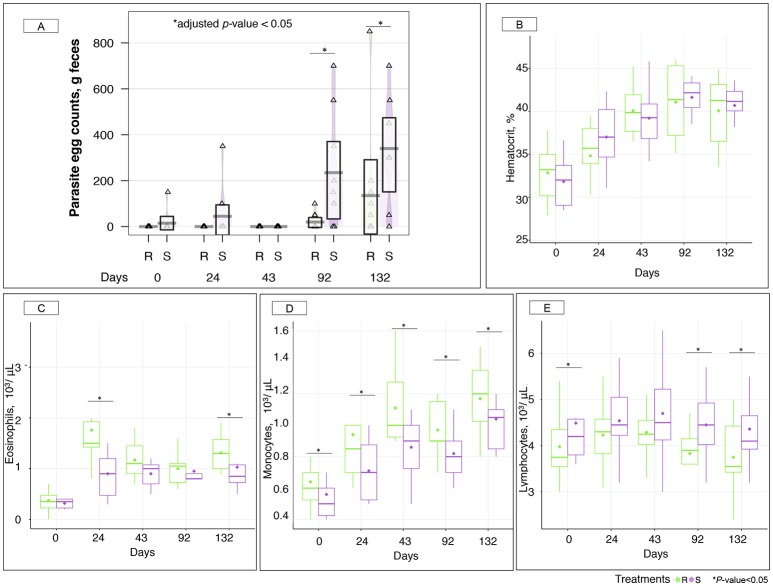
Parasite fecal egg counts and hematological parameters between susceptible and resistant animals across time. (A) Boxplot of the log parasite fecal egg counts (eggs/g feces) in susceptible (S) and resistant (R) animals. Purple and green stand for S and R ponies respectively. *, adjusted p < 0.05 for comparison between S and R ponies in each time point; (B) Hematocrit (%) between S (purple boxes) and R (green boxes) animals across time. The quantification of different type of leukocytes: eosinophils (C); monocytes (D); and lymphocytes (E) were described between susceptible (S, purple boxes) and resistant (R, green boxes) animals across time. In all cases, boxes show median and interquartile range, and whiskers indicate 5th to 95th percentile. *p < 0.05 for comparison between S and R ponies in each time point. Each triangle represents the parasite egg counts of each animal.